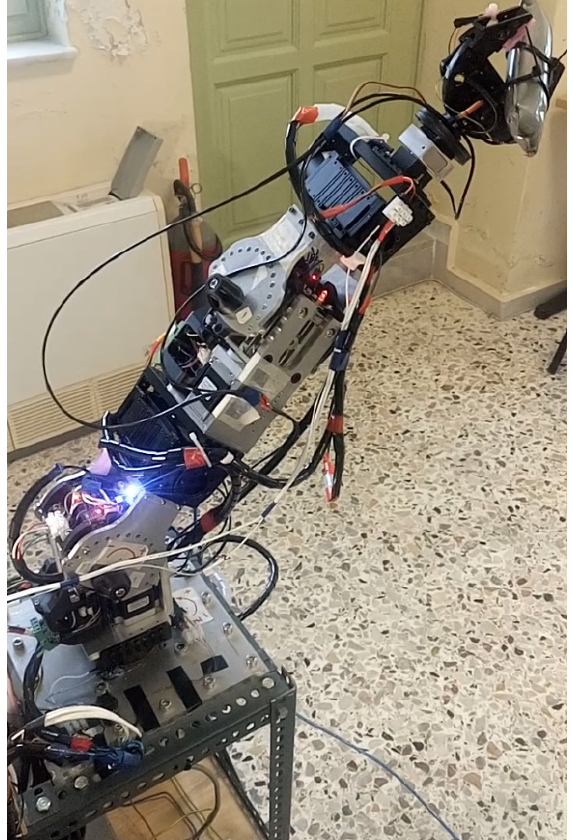
Figure 18. Optimal anatomy of the metamorphic manipulator derived under the MVR measure for Task 2.